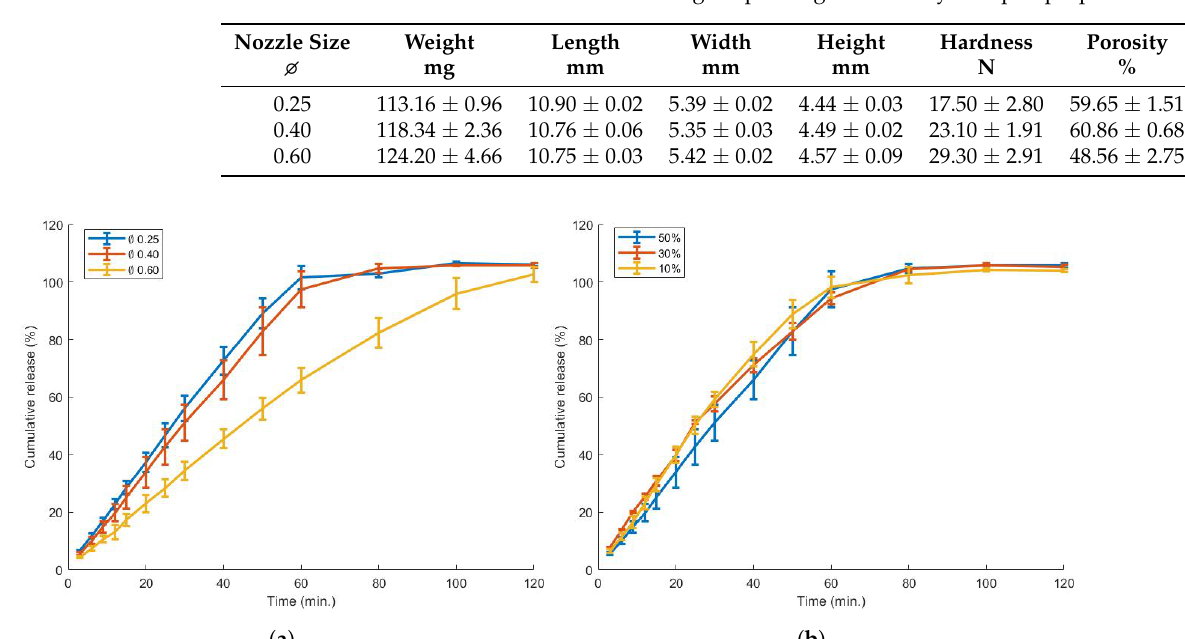
Figure 9. The effect of nozzle size ( a ) and overlap ( b ) on the in vitro dissolution behaviour. A nozzle size of delayed release compared to